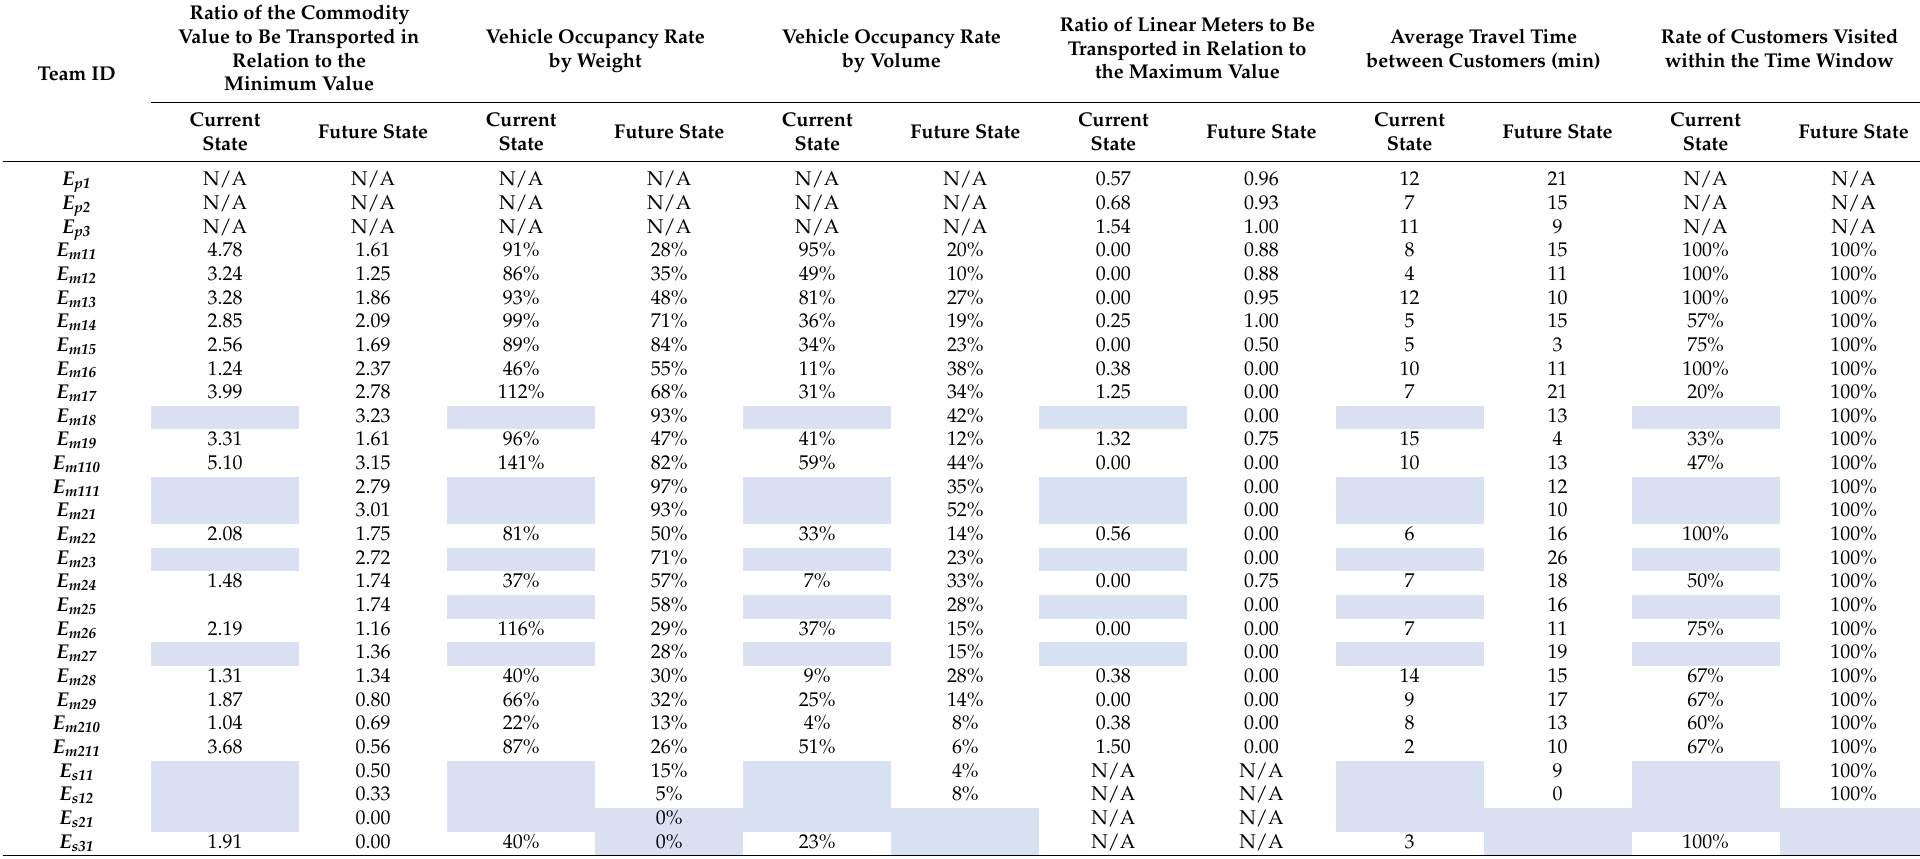
Table 7. Performance indicators for all types of teams in the current and future